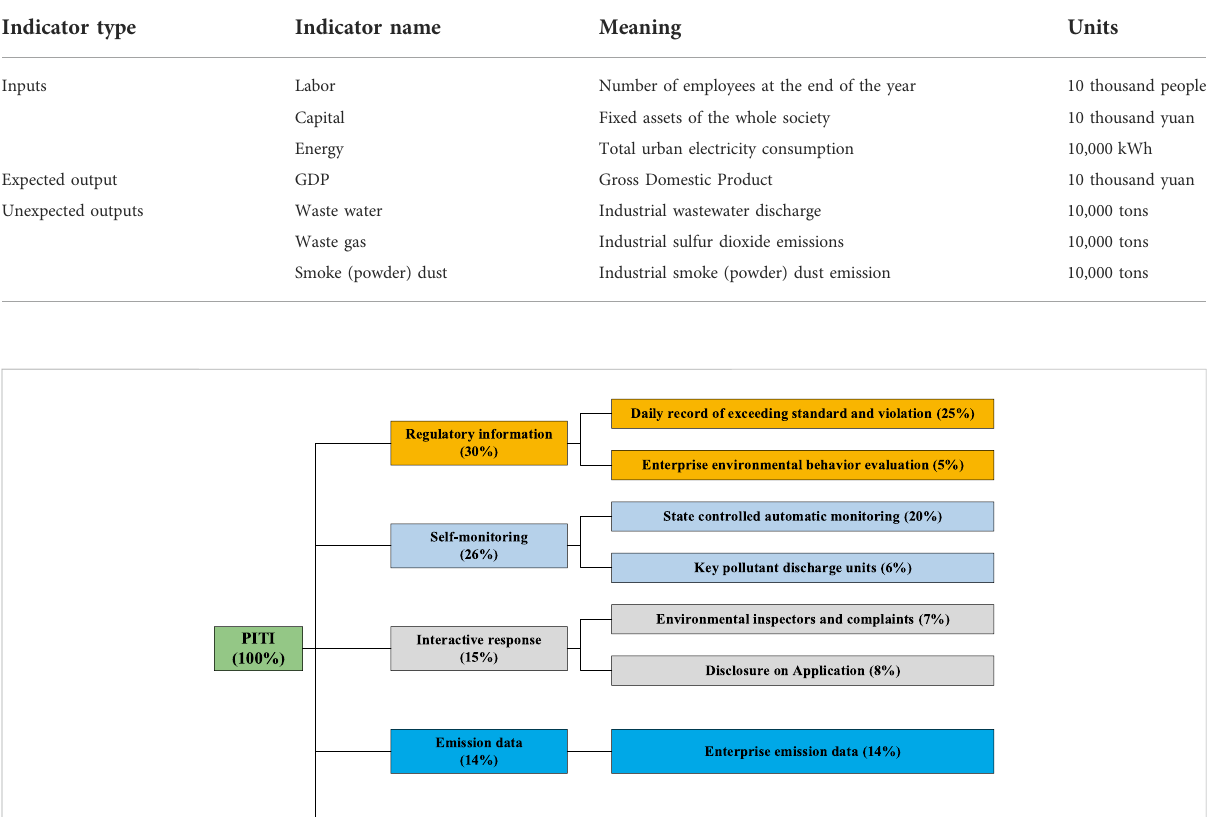
TABLE 1 Input and output indicators system of green energy ef fi ciency.